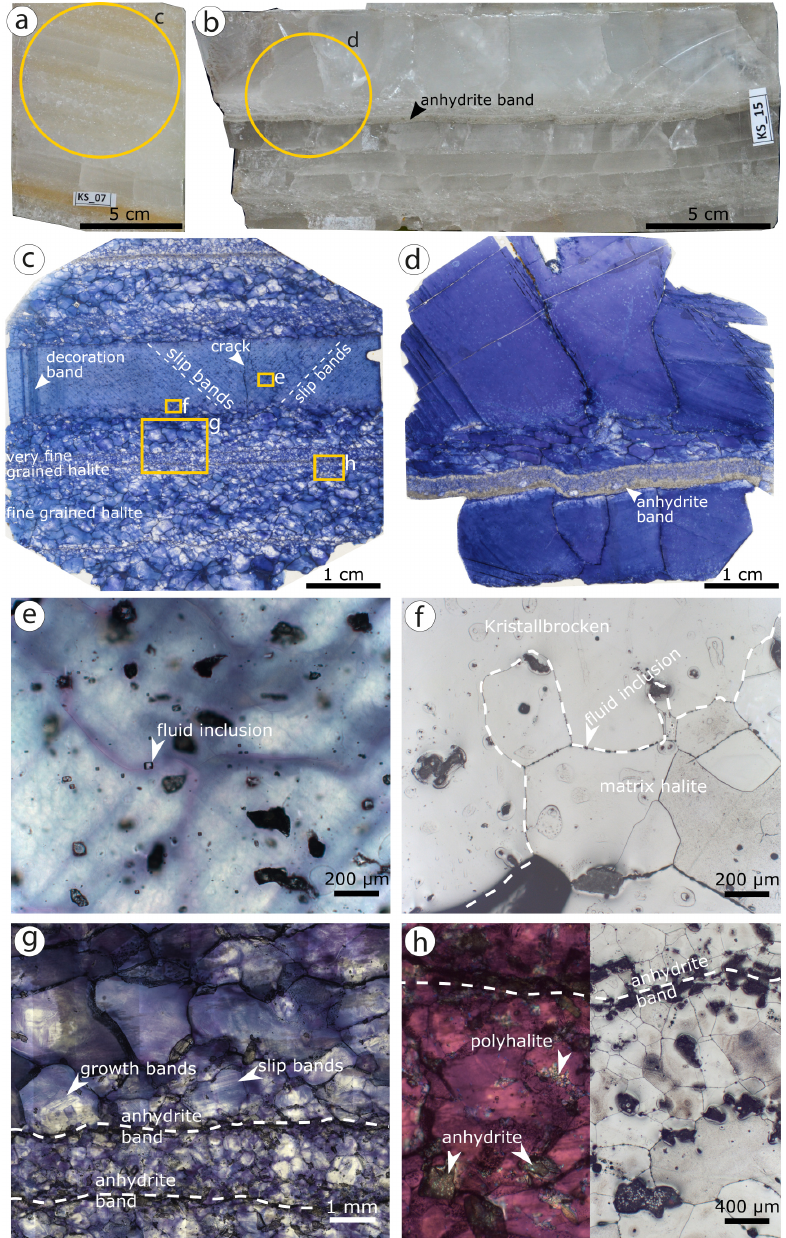
Figure 2. (a) Reflected-light photograph of slabs (KS-07 from Barradeel) used for microstructural analysis showing layered white- and honey-coloured salt with variable grain sizes and milky Kristalllagen with internal lamination. (b) Slab specimen KS-15 of Barradeel used for microstructural analysis showing layered transparent and white salt with Kristalllagen up to 5cm thickness with cracks. Small fold in 5mm thick anhydrite band is bend following the displaced crystal layer. (c) Overview of thin gamma-decorated section of sample KS-07 in transmitted light (location indicated in a ) showing Kristalllagen with abundant inclusions and decorated slip bands, dark-blue decorated bands parallel to crack, and layers of fine- and very fine-grained halite with white cores and blue rims. (d) overview of gamma-decorated thin section of sample KS-15 in transmitted light (location indicated in b ) showing inclusion-poor crystal layers that are slightly displaced and layers of fine-grained halite, with some grains showing a white overgrowth. Anhydrite–halite band is slightly bent and contains abundant halite mineral inclusions of up to 2mm. (e) Micrograph (location indicated in c ) showing gamma-decorated slip bands and blue cellular structures at two different scales, abundant solid inclusions up to 200µm, and fluid inclusions with gas bubbles. (f) Reflected-light image of Kristallbrocken and fine-grained halite with fluid inclusions and anhydrite at grain boundaries. (g) Transmitted-light micrograph showing white cores in halite with growth bands and slip bands. Finely dispersed anhydrite bands are next to very fine-grained halite. (h) Photomontage of transmitted- light image (with λ plate) and reflected-light image showing fluid inclusions at grain boundaries of fine-grained halite, polyhalite, anhydrite, and anhydrite band enriched with small anhydrite minerals. Solid Earth, 14, 271–291, 2023